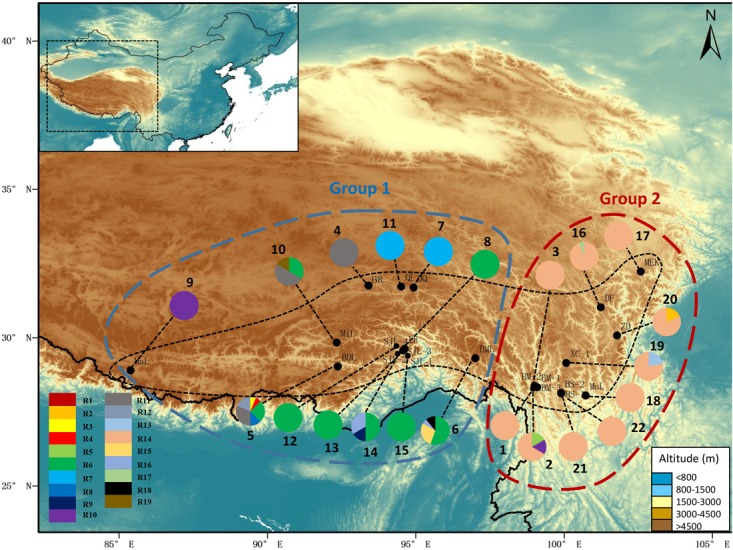
Map showing the sites of sampled populations and the geographic distribution of ribotypes of R. fastigiata based on the ITS dataset. Pie charts show the proportion of ribotypes within each population. The numbers besides the circles represent population number as in Supplementary Table S1. Dashed line on the map indicates the distribution area of R. fastigiata. The two geographic groups defined by the SAMOVA analysis are also indicated by colored dashed lines.